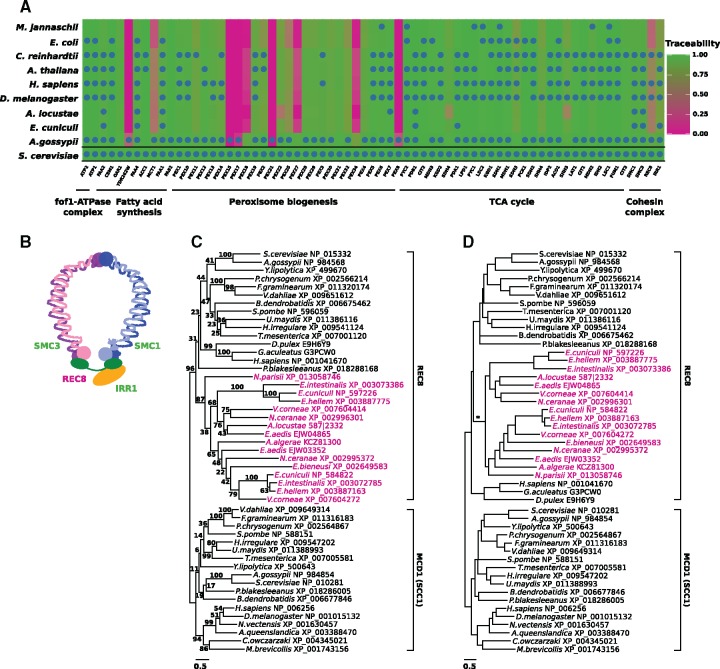
—(A) Phylogenetic profiles for the components of fungal key metabolic pathways across ten representative species from the tree of life. The background color gives the information of traceability index ranging from green (high traceability) to red (low traceability). (B) The four proteins of the yeast cohesin complex form a ring-like structure. Font color of the protein names indicates that TI(t) in the microsporidium Encephalitozoon cuniculi is either 0.75 or higher (green), or below (red). (C) Maximum likelihood tree of REC8 and MCD1 (syn. SCC1) orthologs. The microsporidian REC8 candidates are colored in red. Branch labels represent percent bootstrap support. (D) Alternative phylogeny for the REC8/MCD1 (SCC1) protein family. It features monophyletic fungal REC8 and MCD1 (SCC1), respectively. The animal REC8 proteins are placed as sister to monophyletic fungal and microsporidian REC8 proteins. The branching orders in the fungal subtrees follow the accepted species phylogeny. The alternative tree is with a ΔLogLikelihood = 25.7 not significantly worse than the ML tree shown in (C) (Shimodaira–Hasegawa test: P > 0.05). The asterisk indicates a gene duplication on the microsporidian lineage that gave rise to the two paralogous microsporidian REC8 lineages.